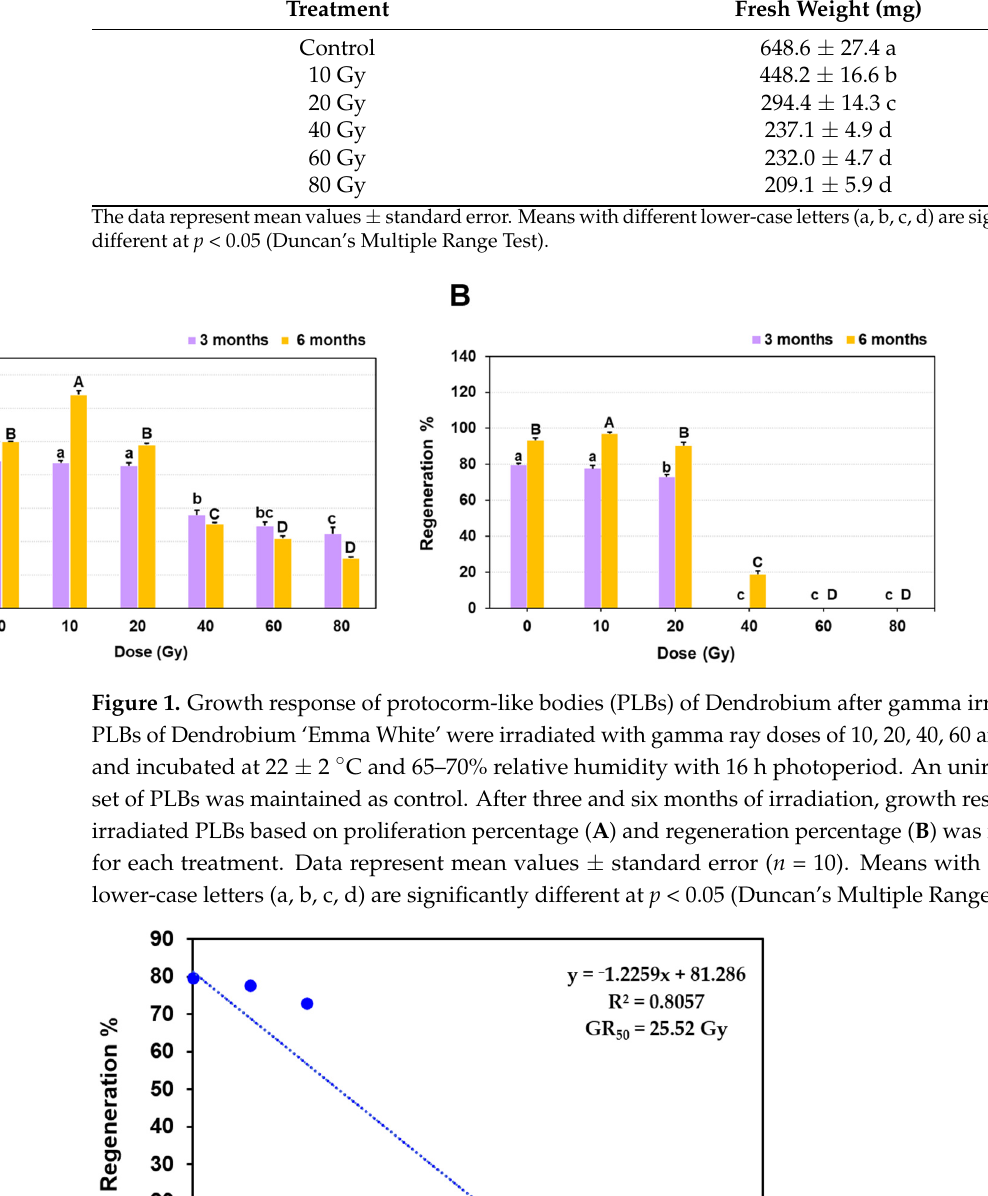
optimal dose range of 10 to 25 Gy for irradiation of Dendrobium ‘Emma White’ PLBs.